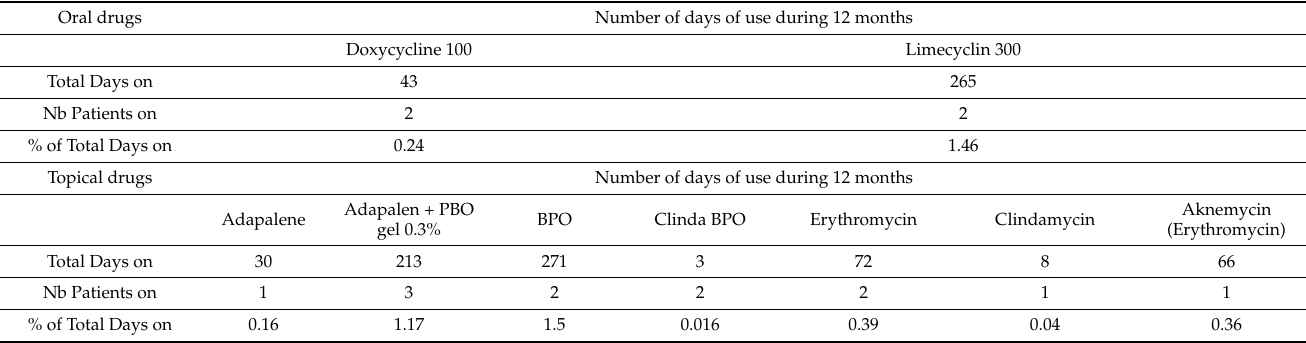
Table 1. Oral and topical drugs used (days) during the 12-months follow-up